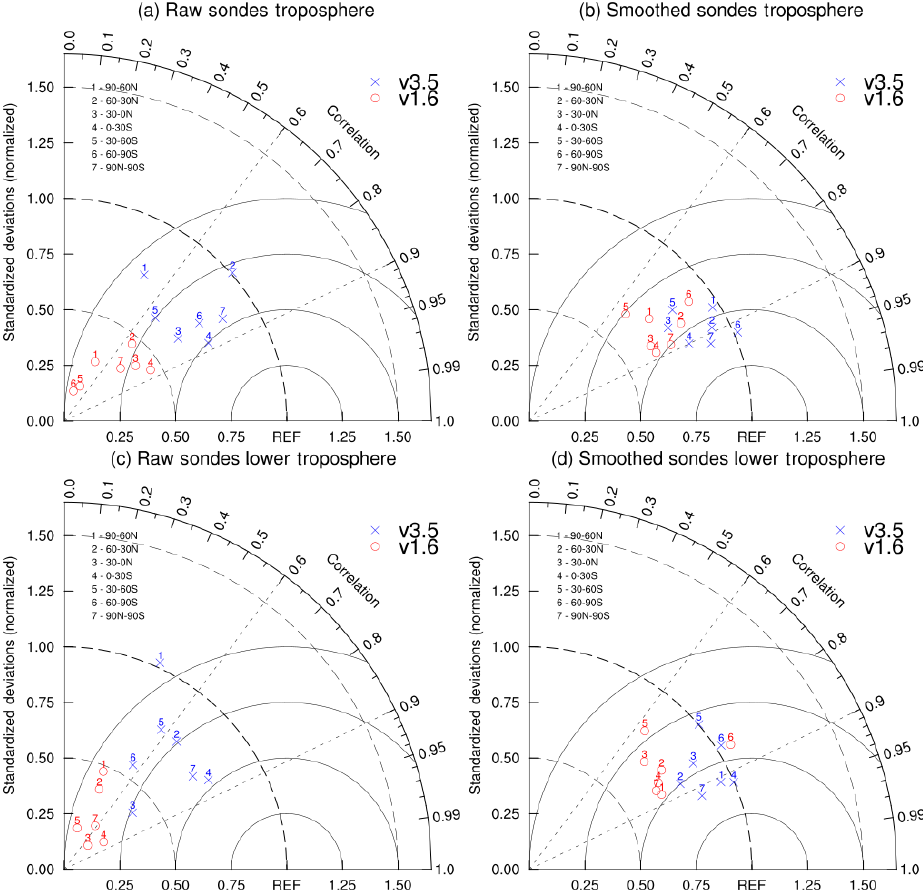
Figure 4. Taylor diagrams for (a, b) tropospheric columns and (c, d) lower tropospheric columns. (a, c) Raw sonde data, (b, d) smoothed sonde data. Red circles indicate v1.6; blue crosses indicate